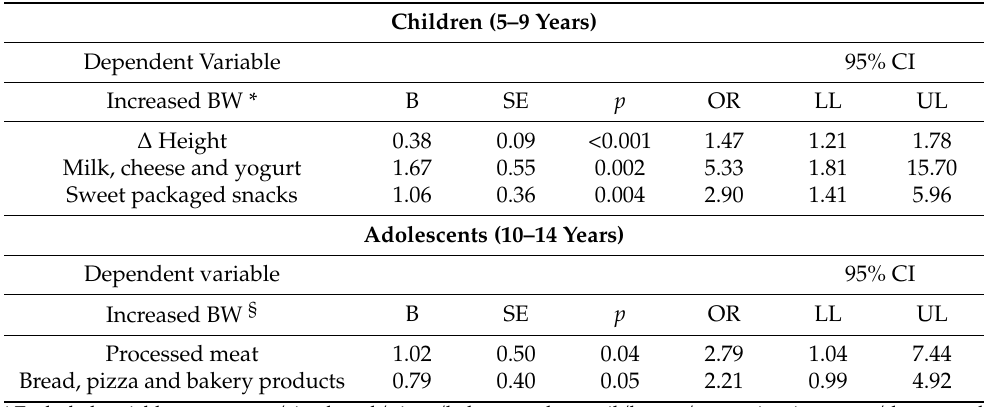
Table 3. Logistic regression analysis: dietary changes and other factors associated with body weight increase according to age group during the first COVID-19